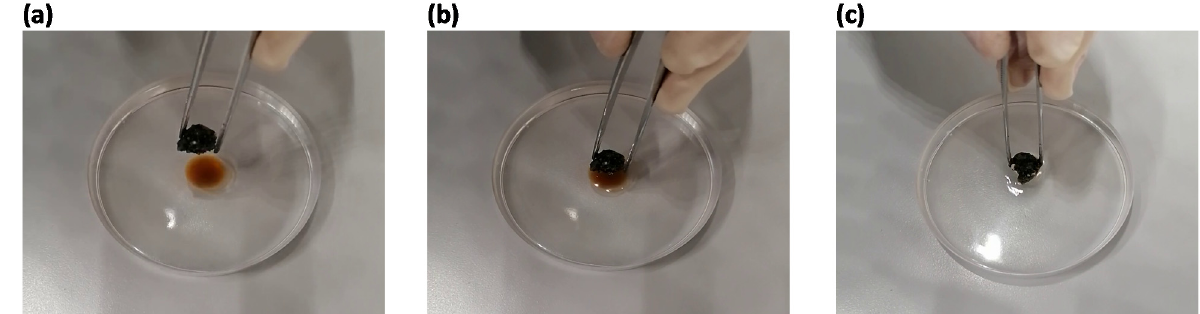
Figure 6. ( a ) Photograph of composite 3 before entering into contact with the surface; ( b ); photograph of composite 3 during contact with the surface. ( c ) Photograph of composite 3 after contact with the surface.